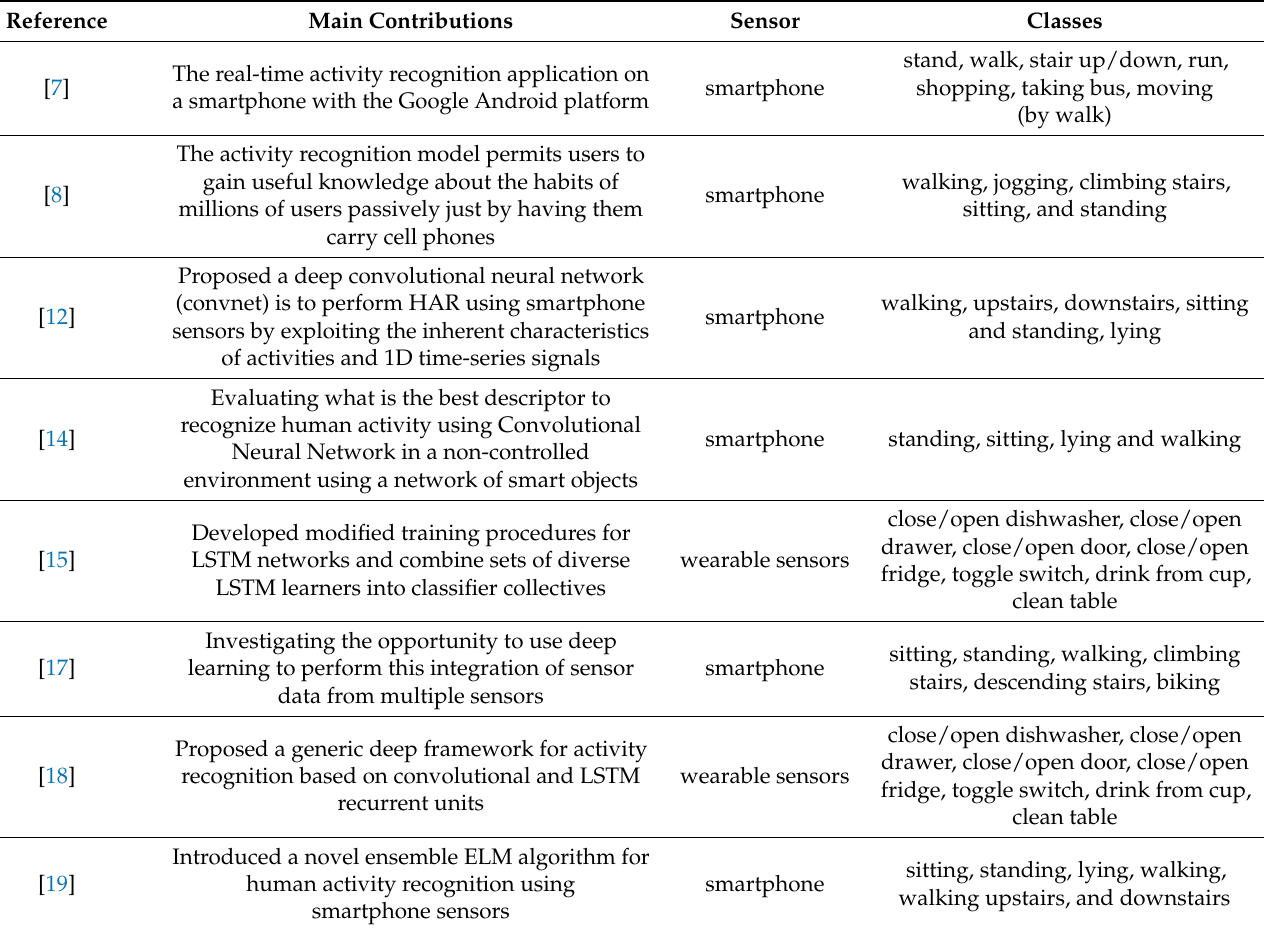
Table 1. The comparison of related